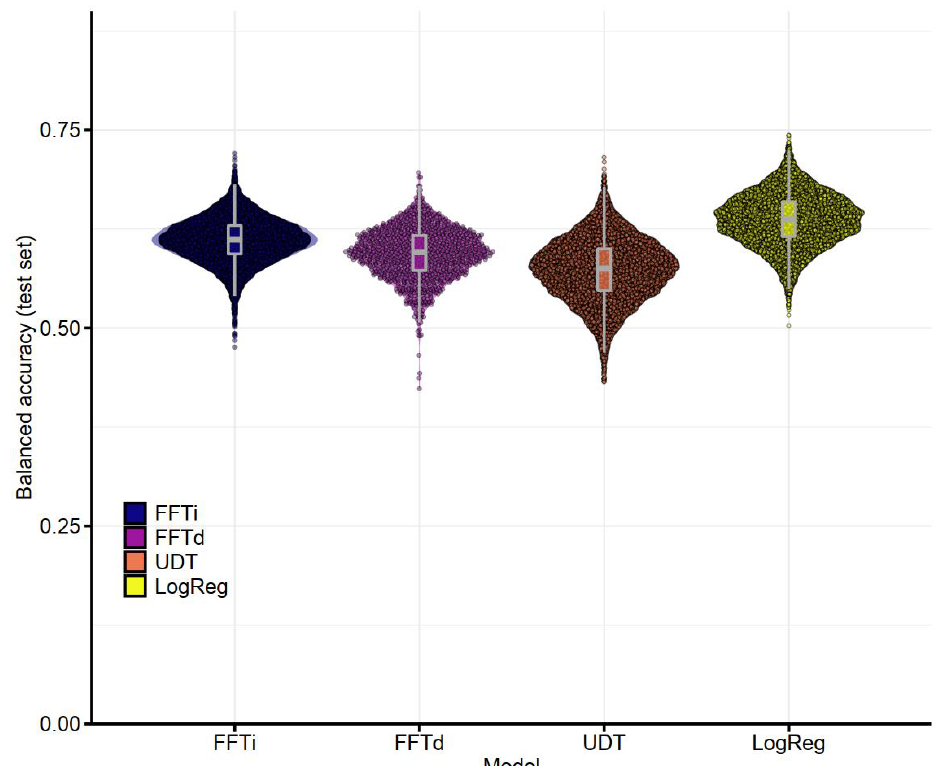
M—mean, SE—standard error of the mean, FFTi—fast-and-frugal tree construction using the ifan algorithm, FFTd—fast-and-frugal tree construction using the dfan algorithm, UDT—unconstrained decision trees based on the CART algorithm, LogReg—logistic regression.